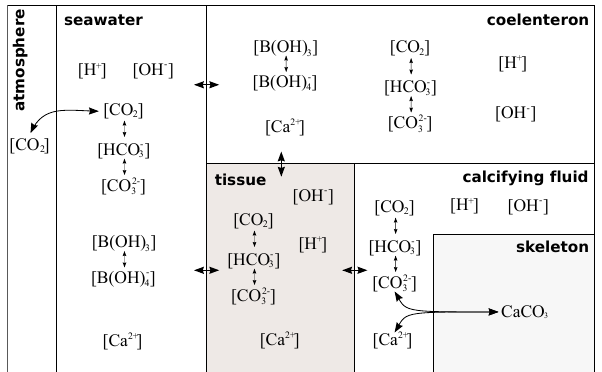
Fig. 1. Schematic of the coral polyp model. Four boxes are consid- ered in the model (seawater, coelenteron, tissue, calcifying fluid), which are interconnected via fluxes over the boundary layers. The seawater compartment is connected to an atmosphere with prede- fined p CO 2 . Precipitation of the coral skeleton (calcification) oc- curs in the calcifying fluid. State variables and fluxes are described in the